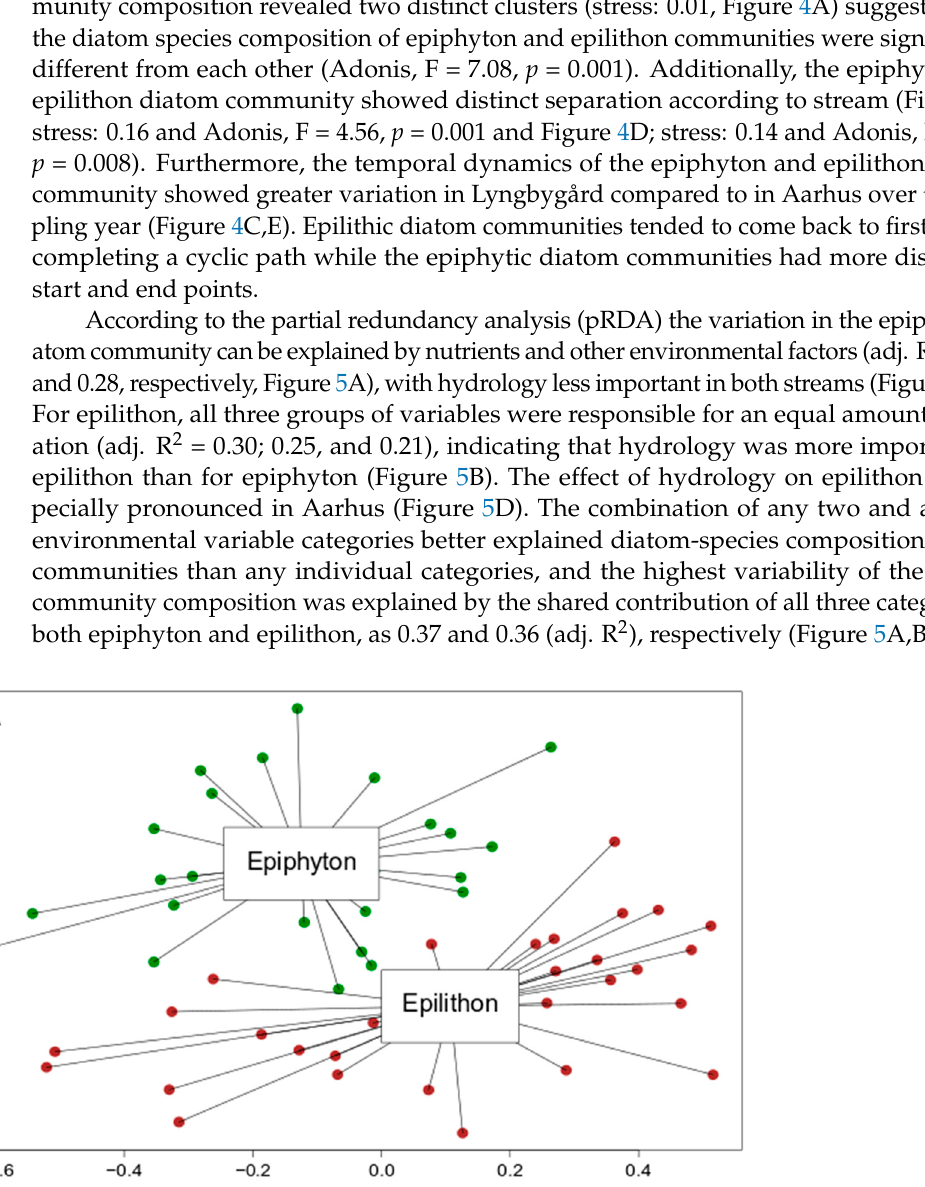
Figure 4. Differences in diatom species composition and trajectories of community change over the study year. ( A ): epi- phyton and epilithon diatom species composition; ( B ): epiphytic diatom communities in two streams; ( C ): trajectories of epiphytic community change over the study year; ( D ): epilithic diatom communities in two streams and ( E ): trajectories of epilithic community change over the year. According to the partial redundancy analysis (pRDA) the variation in the epiphytic diatom community can be explained by nutrients and other environmental factors (adj. R 2 = 0.20 and 0.28, respectively, Figure 5A), with hydrology less important in both streams (Figure 5C,E). For epilithon, all three groups of variables were responsible for an equal amount of variation (adj. R 2 = 0.30; 0.25, and 0.21), indicating that hydrology was more important for epilithon than for epiphyton (Figure 5B). The effect of hydrology on